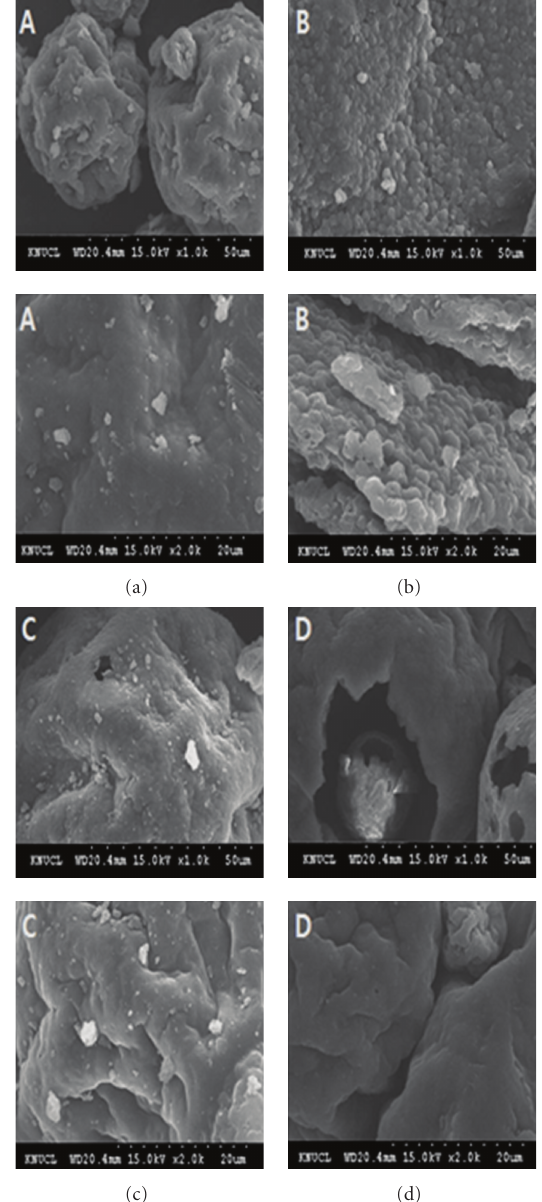
Figure 7: Scanning electron micrograph (SEM) of Scenedesmus sp. after several extraction processes (top: 1000x, bottom: 2000x); (a) control (only solvent extraction without any pretreatment), (b) solvent extraction with homogenization pretreatment, (c) solvent extraction with microwave pretreatment, and (d) solvent extraction with ultrasonification